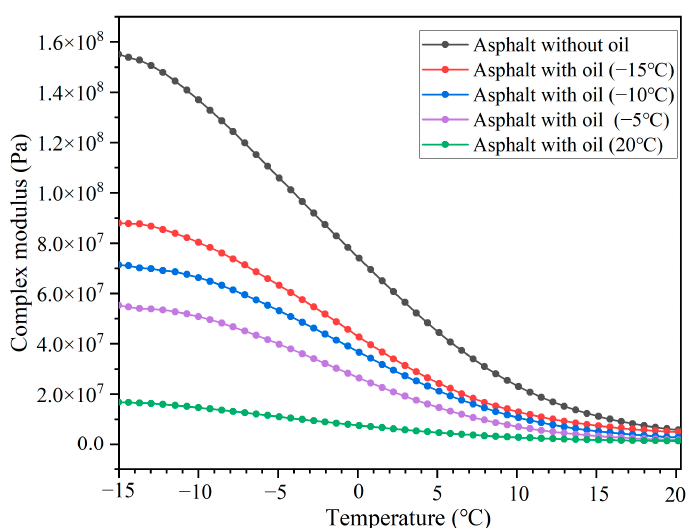
Figure 13. Complex modulus of asphalt binder after loading with 64,000 cycles under different service temperature conditions.